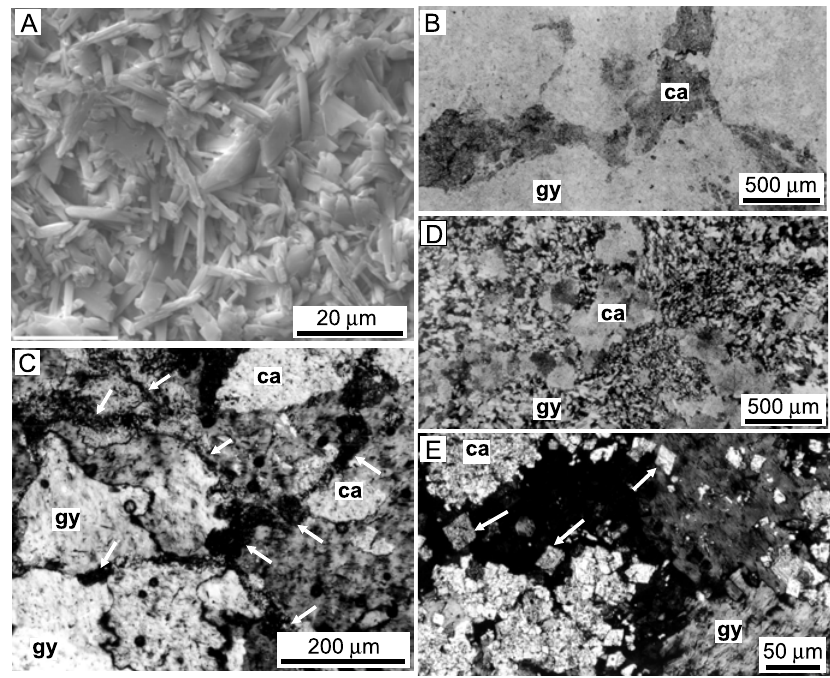
Fig. 9 – Textures of the evaporites from the Codó Formation exposed in the study areas. A) SEM view of the pseudo-nodular anhydrite or gypsum, with lath-like anhydrite (an) interlaced with gypsum (gy). This material comes from a nodule of anhydrite depicted in figure 8C. B) Calcite (ca) cementing fractures in the pseudo-nodular anhydrite or gypsum (gy). C) Detail of the pseudo-nodular anhydrite or gypsum showing several fractures (arrows) filled by a mixture of calcite and muds. Note larger calcite crystals (ca) that grew sidewards fromthefracturestroughreplacementofgypsum(gy). D)Relicsofcalcite(ca)withinalabastrinegypsum(gy)fromthepseudo-nodular anhydrite or gypsum. E) Rhombs of calcite after dolomite (arrows). (Except for the SEM micrography shown in A, all the other figures were obtained under petrographic microscope with crossed